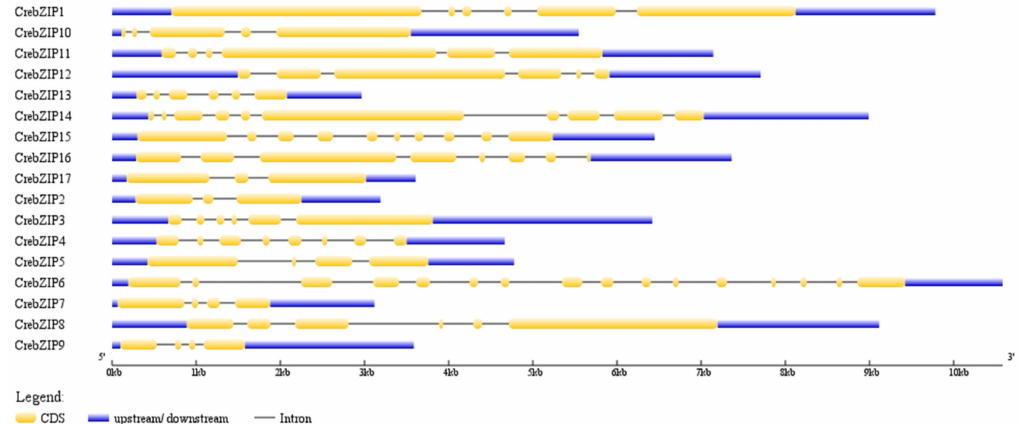
Figure 3. The Exon-intron organization of CrebZIP genes. The exons and introns are represented by yellow boxes and horizontal black lines, respectively. Untranslated regions are shown with blue boxes. The length of CrebZIP genes are indicated by the horizontal axis (kb). Chromosome assignment of CrebZIP genes depicted by MapInspect software displayed 17 CrebZIP genes unevenly distributed on nine chromosomes of C. reinhardtii . Three CrebZIP genes